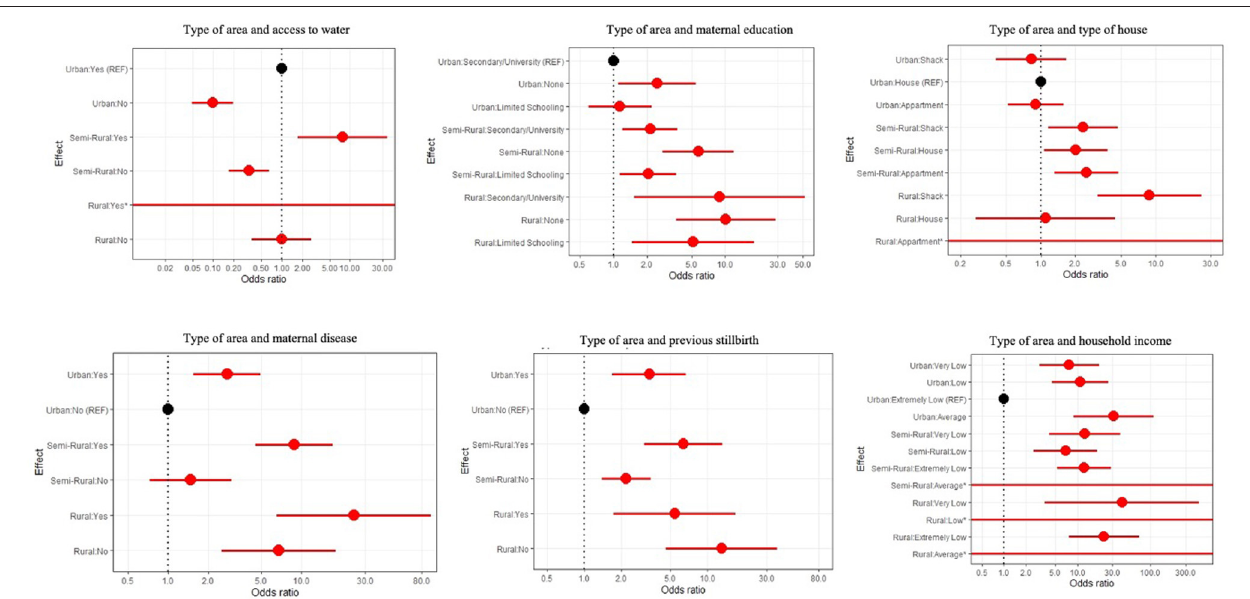
FIGURE 2 | Forest plots for area type and the following confounding variables: access to clean water, maternal education, type of house, maternal disease, previous stillbirth(s), and household